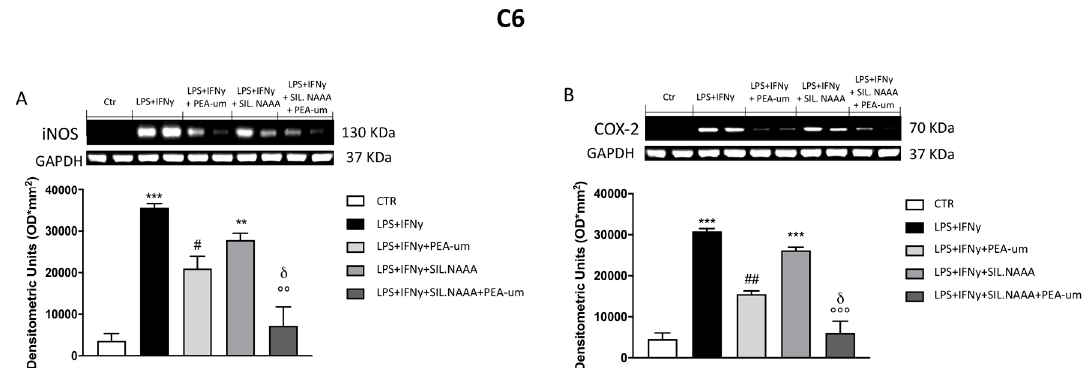
Figure 4. Effect of PEA-um treatment and NAAA-siRNA knockdown on the expression of iNOS and cyclooxygenase 2 (COX-2) in C6 rat glioma cells. iNOS and COX-2 levels were increased in LPS/INF- γ group, whereas treatment with PEA-um at the concentration of 10 μ M significantly reduced these expressions ( A , B ). Blots revealed a significant increase of iNOS and COX-2 in LPS/INF- γ group, in which the cells were NAAA-silenced ( A , B ); meanwhile, their expression was attenuated in group treated with PEA-um 10 μ M ( A , B ). Data are representative of at least three independent experiments. p < 0.001 versus LPS / INF- γ + silenced NAAA; δ p < 0.05 versus LPS / INF- γ + NAAA silencing + PEA-um treatment.